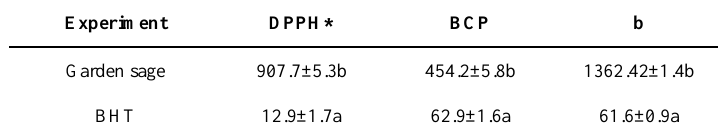
Table 1. Anti-oxidant activity (IC50 ± SD μg/ml) of garden sage essence and BHT in various models